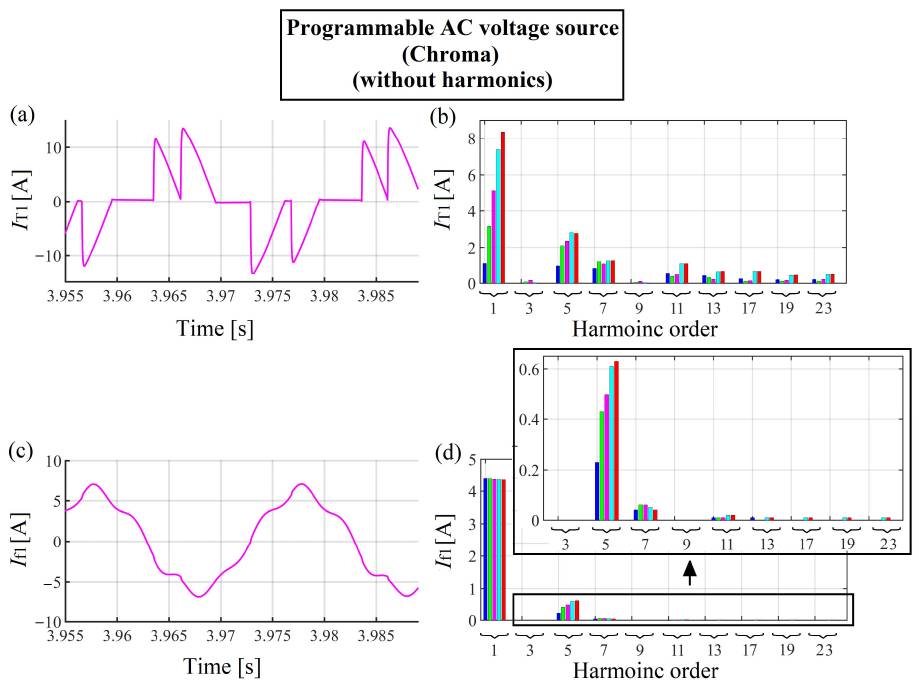
Figure 28. ( a ) Rectifier input current waveform with ( b ) its spectrum, ( c ) filter current waveform with ( d ) its spectrum .